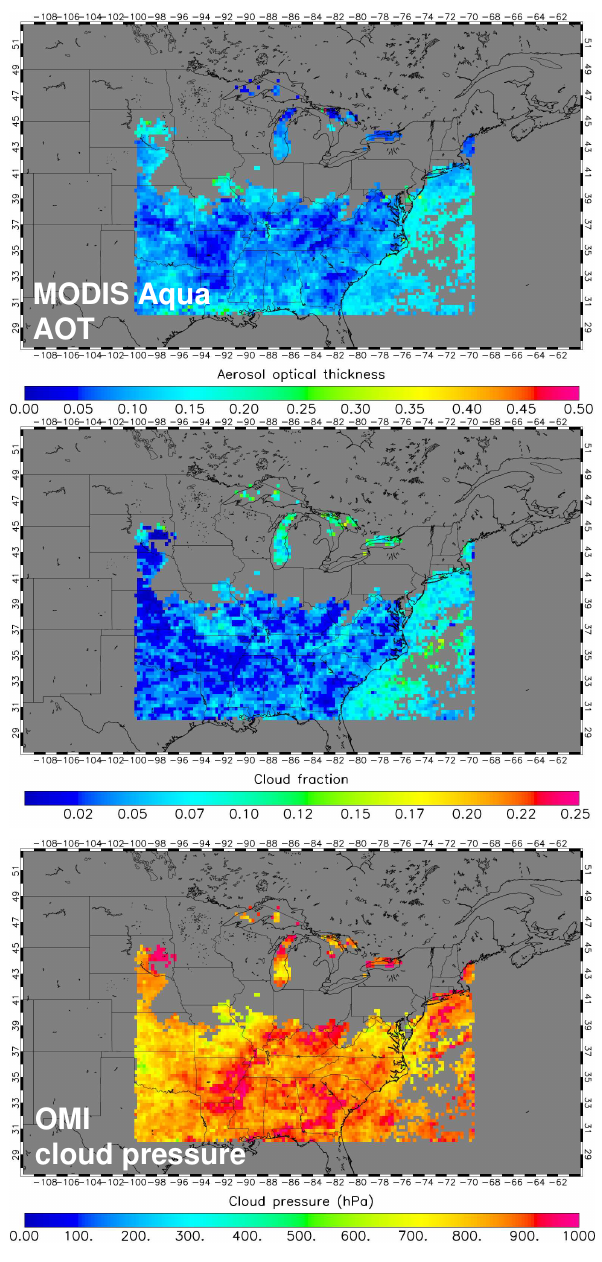
Fig. 15. Monthly average aerosol optical thickness observed from MODIS Aqua (upper panel), and corresponding OMI O 2 -O 2 effective cloud fraction (middle panel) and effective cloud pressure (lower panel) for January 2005. Cloud fractions have been selected only for those days and locations that had a successful, cloud-free, MODIS AOT retrieval 15 minutes prior to OMI. Grey areas indicate less than 3 successful coincidences in January